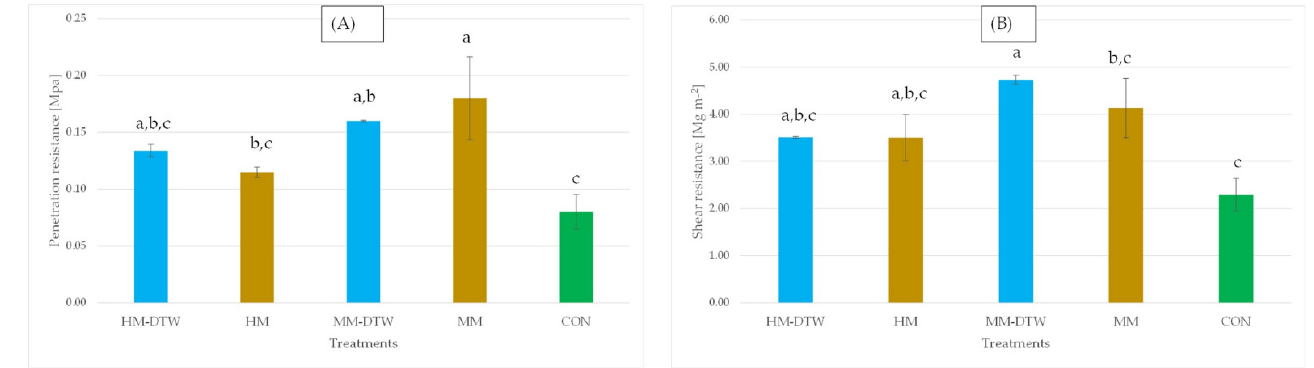
Figure 3. Penetration resistance ( A ) and shear resistance ( B ) for the different treatments. Obtained p -values from ANOVA were p = 0.00041 for penetration resistance and p = 0.00012 for shear resistance. Different letters indicate homogeneous groups ( p < 0.05) according to HSD Tukey test (HM-DTW—areas identified as sensitive by DTW algorithm and harvested with high mechanisation level; HM—areas not identified as sensitive by DTW algorithm and harvested with high mechanisation level; MM-DTW—areas identified as sensitive by DTW algorithm and harvested with medium mechanisation level; MM—areas not identified as sensitive by DTW algorithm and harvested with medium mechanisation level; CON—control area consisting of unharvested oak coppice in the last 20 years located close to the two parcels). Different lowercase letters indicate different homogeneous groups at p < 0.05 according HSD Tukey